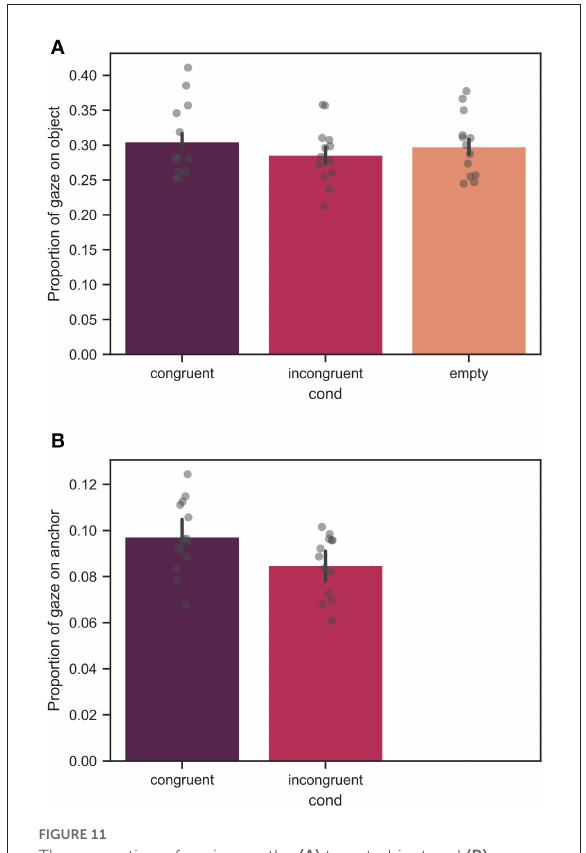
FIGURE11 The proportion of gazing on the (A) target object and (B) relevant anchor across all trials, averaged over all measured participants. Each bar corresponds to a separate experimental condition. The error bars indicate confidence intervals of 95% computed using bootstrapping (see main text). The individual points correspond to the mean value for each individual participant. The difference in (A) between the congruent and incongruent conditions was significant with p < 0.01, whereas no significant difference was found between the congruent and empty conditions. Note, that in (B) the proportion of gazing on the relevant anchor is shown only for the context-rich conditions as in the empty condition no anchor was present. There was a significant difference for the proportion of gazing on the relevant anchor with p < 0.05.